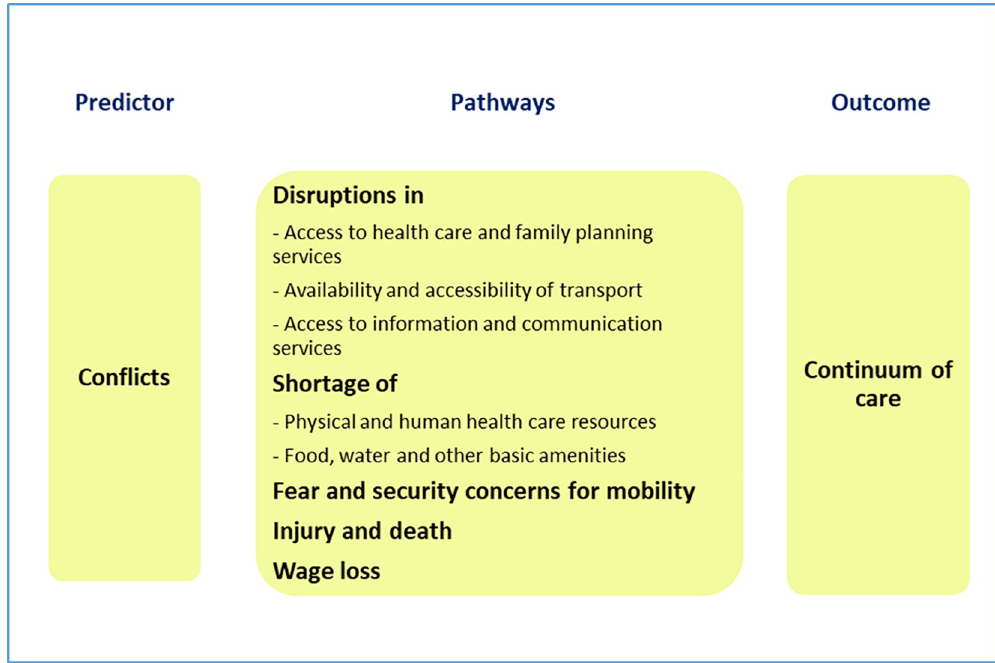
Fig 1. AU : PleasecorrectthefollowingwordsinFig 1 andprovideanewFig 1 file : DistruptionstoDisruptionsaccessabilitytoaccessibilityContinumntoContinuum Logic model showing the influence of conflict on maternal CoC. CoC AU : AbbreviationlistshavebeencompiledforthoseusedinFigs 1 (cid:0) 4 : Pleaseverifythatallentriesarecorrect : , continuum of care.